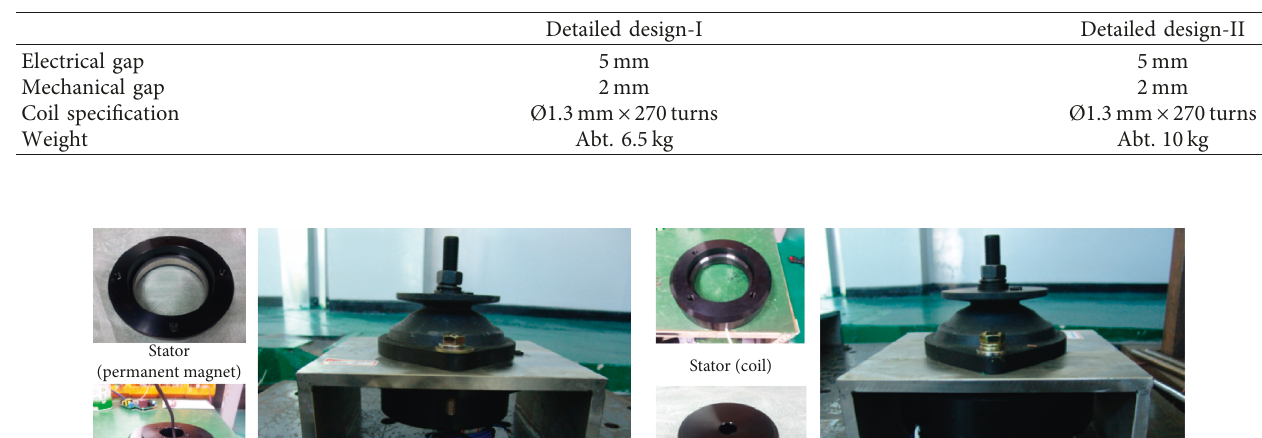
Figure 4: Schematic drawings for detailed design. (a) Detailed design-I. (b) Detailed design-II. Table 2: Details of suggested actuator.